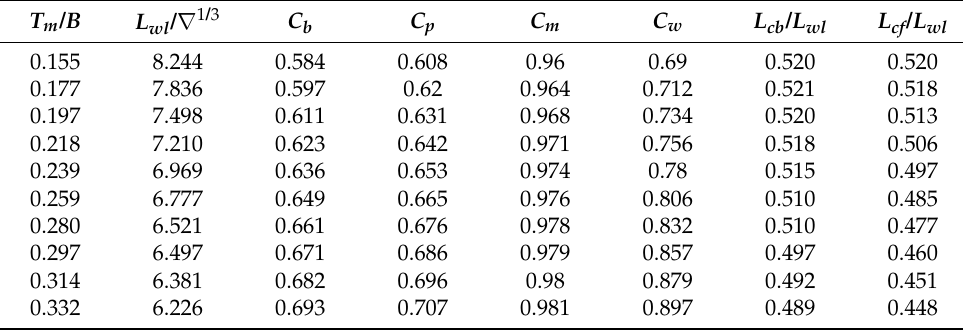
Table 3. Model ship dimensionless features at different drafts.